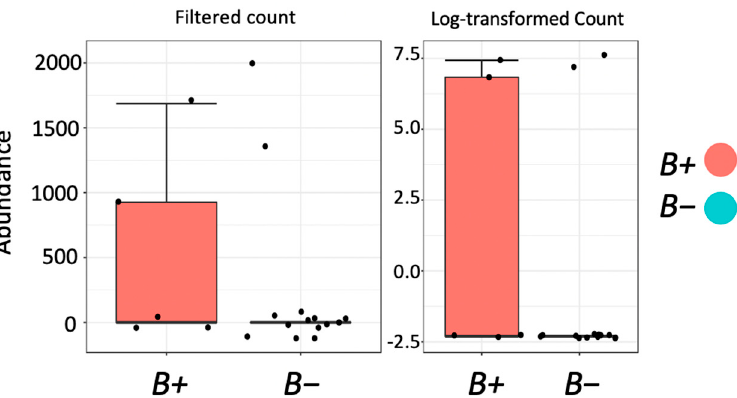
Figure A2. Box-plots showing the filtered count and log transformed counts from MetagenomeSeq data of the genus Anaerocella. This was the only bacterial taxon positively associated with Blastocystis colonisation in the study cohort ( p < 0.05). Red plots reflect B + data, and blue plots represent B - data.